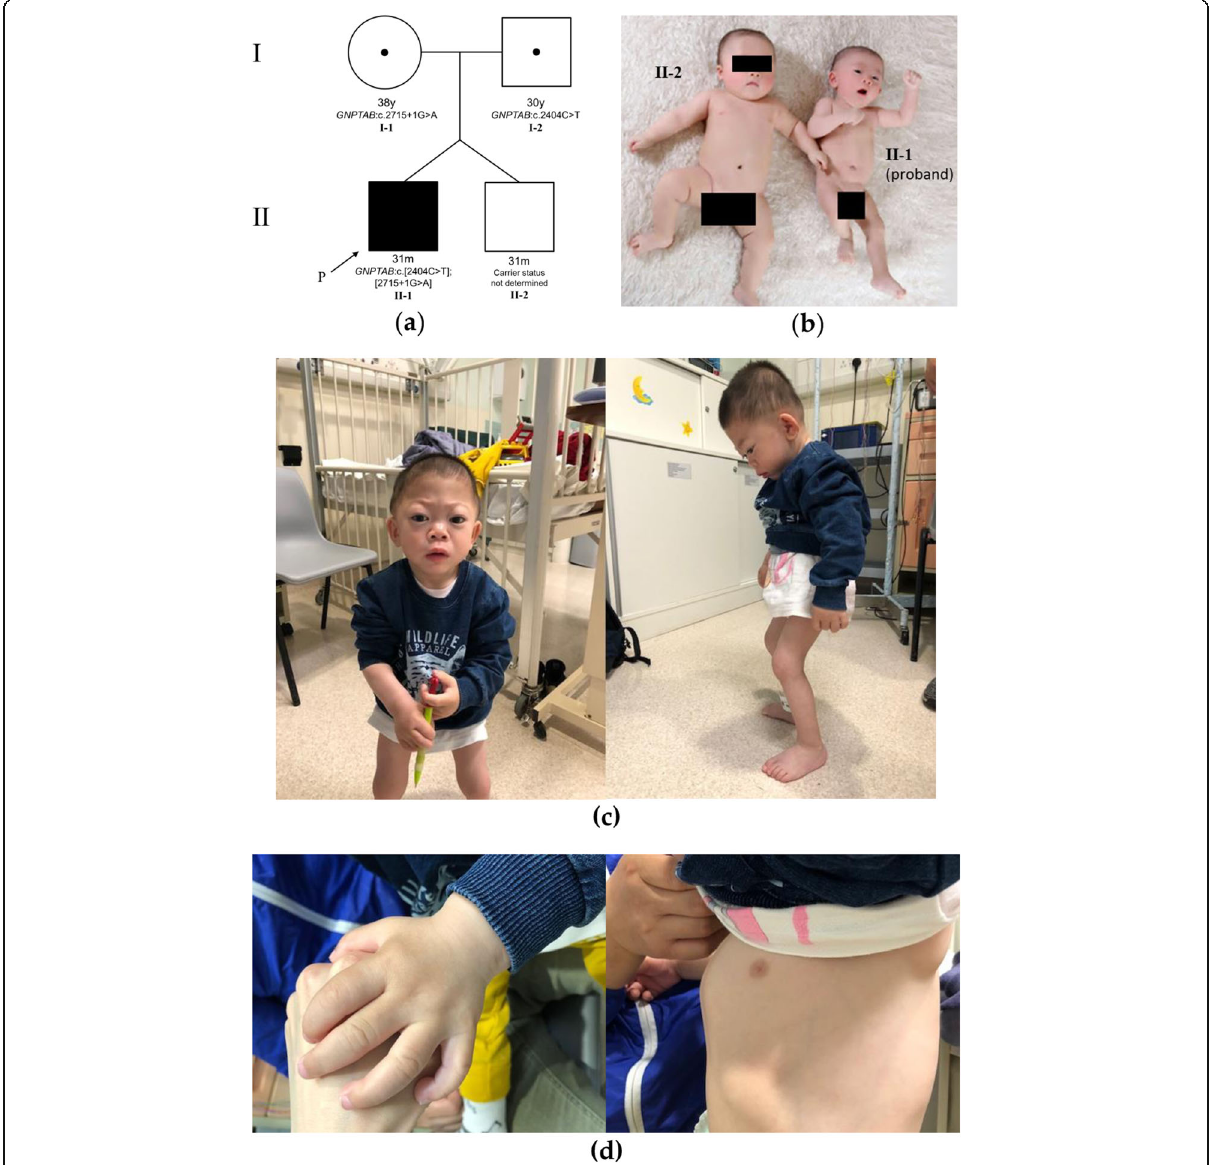
Fig. 1 Clinical progression of the mucolipidosis III alpha/beta phenotype. a Pedigree of the family. Both parents were confirmed to be heterozygous carriers of the respective pathogenic variant. b The twin brother (II-2) and the proband (II-1) at four months of age. The current photo shows a clear lack of catch-up growth even at four months of age for the proband Note that facial dysmorphism was minimal. c At 24 months of age, the coarsening of facial features, trigonocephaly, flat nasal bridge and prominent eyes became more apparent (left). The kypho-lordosis, crouched gait with bent knee posture was seen on standing. Claw-hand deformities were seen (right) ( d ) Close-up view of the thick claw hand of the patient (left) and pectus carinatum deformity of the chest wall